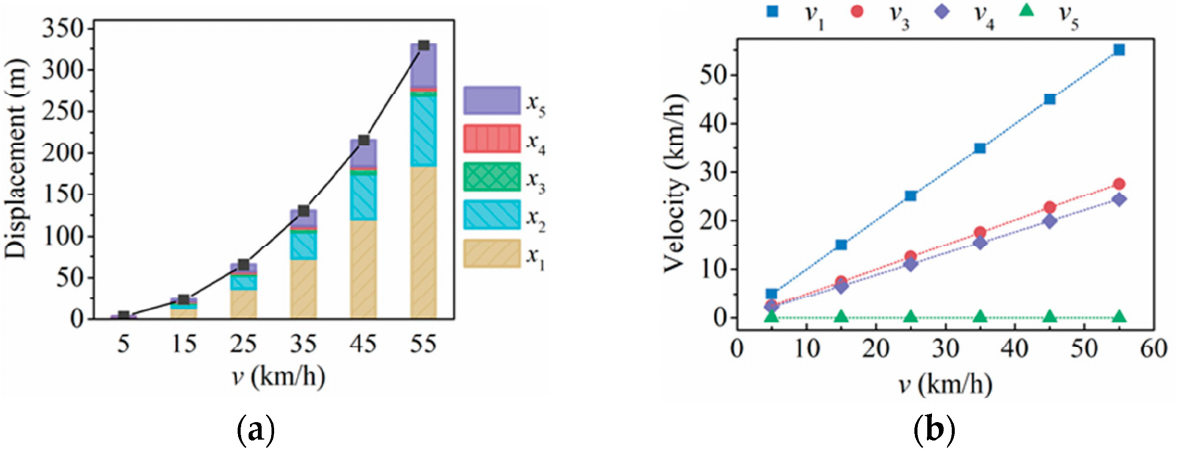
Figure 14. The influence of the impact velocity on the dynamic response: ( a ) displacement, ( b )